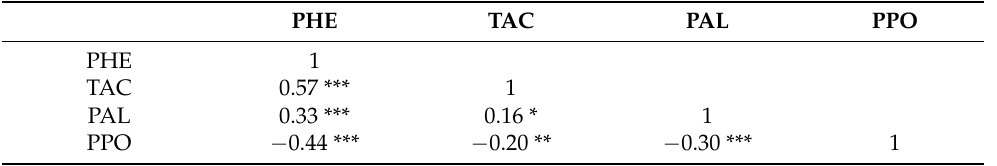
Table 6. Pearson correlation coefficients (r) and corresponding significance levels between the measured biochemical parameters in 2019/2020. PHE TAC